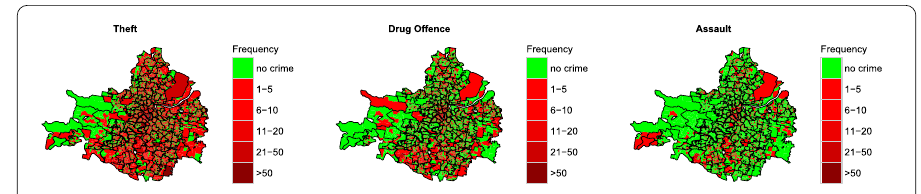
Figure 1 Spatial distribution of different types of crime event in Brisbane